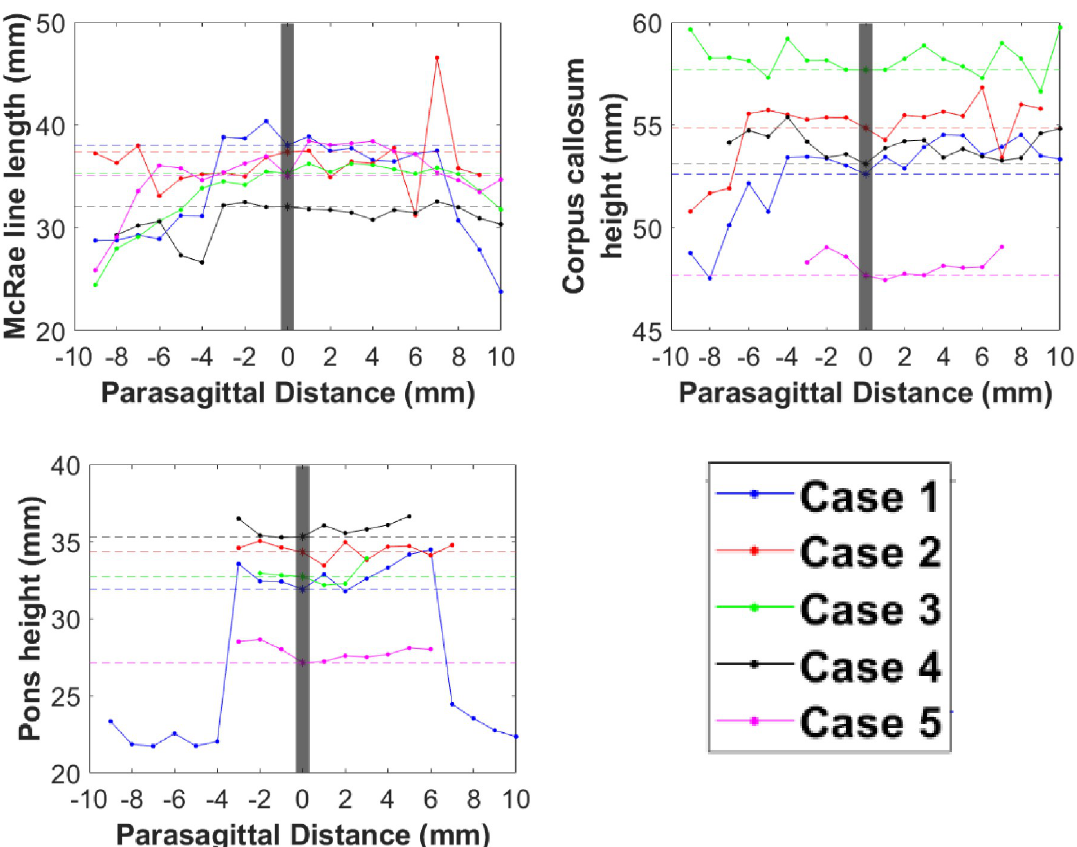
Fig 5. Symmetry plots showing parameters that maintain lateral symmetry up to 4 mm from the midsagittal